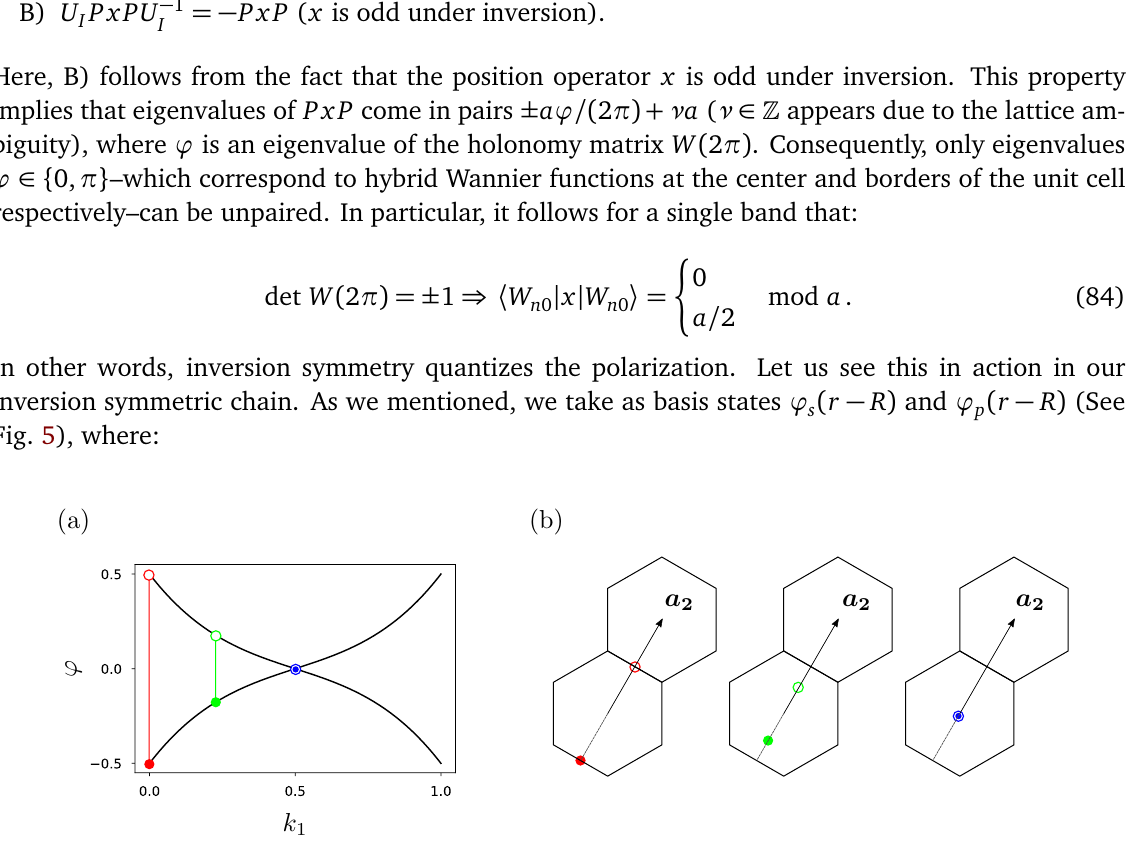
) for a set of 2 bands in a honey- Figure 4: Eigenvalues of the holonomy W k 1 , k 2 = 0 ( G 2 comb lattice model [ 20, 21 ] . (a) Spectrum as a function of k , where vertical lines 1 indicate different choices of k ; two eigenvalues correspond to each choice, denoted 1 by the solid circle and ring. (b) Interpretation of eigenvalues in terms of hybrid Wannier